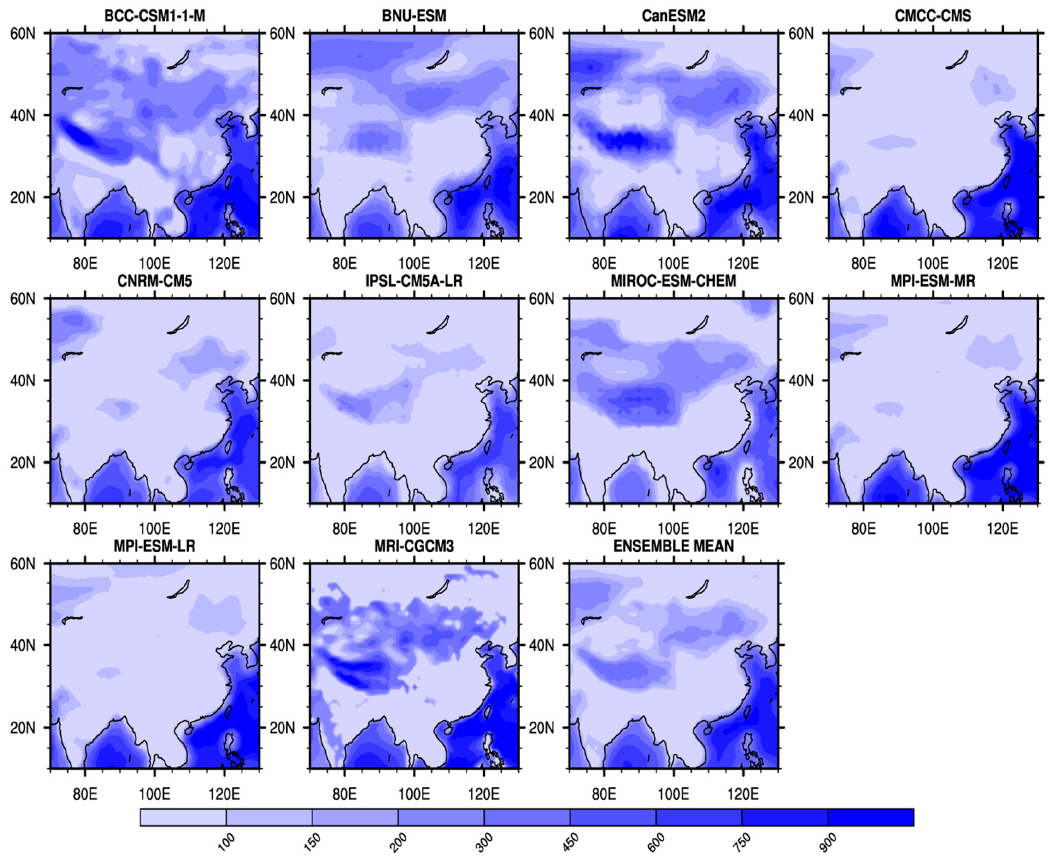
Figure A1. Spatial distribution of mean wind power density (WPD) in W / m 2 based on 90 m above ground level extrapolated wind speed for the historical period of 1950–1980 for the CMIP5 models and their ensemble